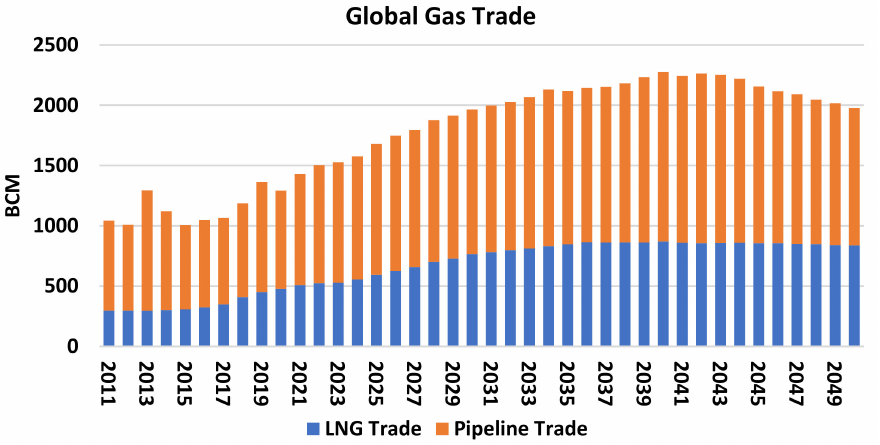
Figure 17. Global gas trade forecasted by G2M2 ®